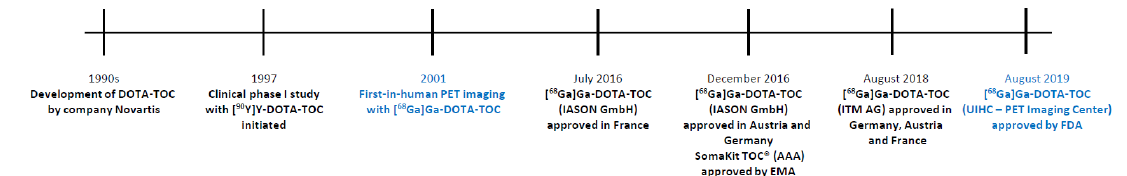
Figure 2. DOTA-TOC timeline. The first use for in-human imaging with [ 68 Ga]Ga-DOTA-TOC and its FDA approval are highlighted in blue.